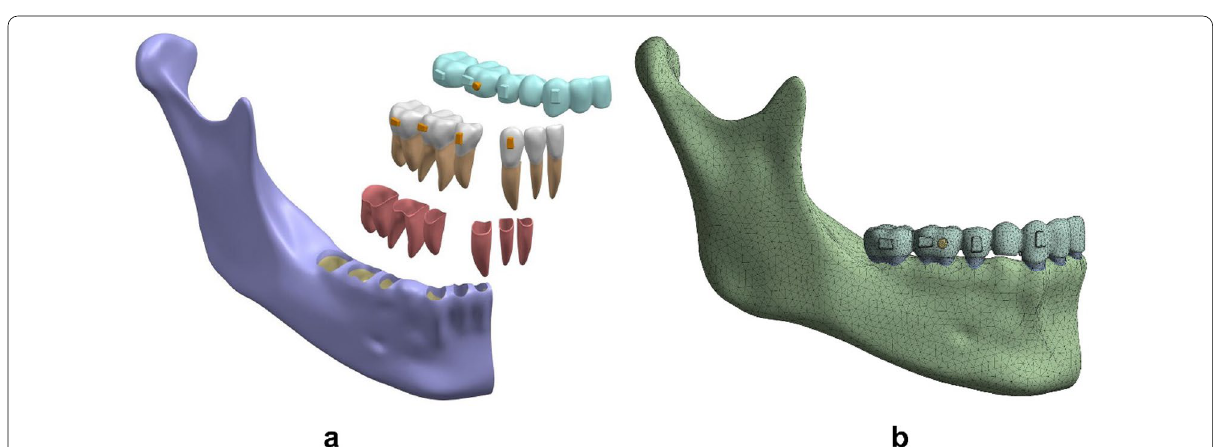
Fig. 3 a Geometric model assembly of the aligner, teeth, PDL, mandible, attachments and the button. b the 3D finite element